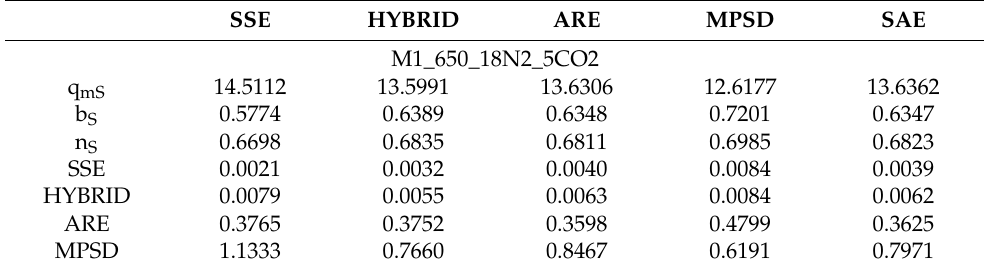
Table 5. Sips isotherms constants with error analysis